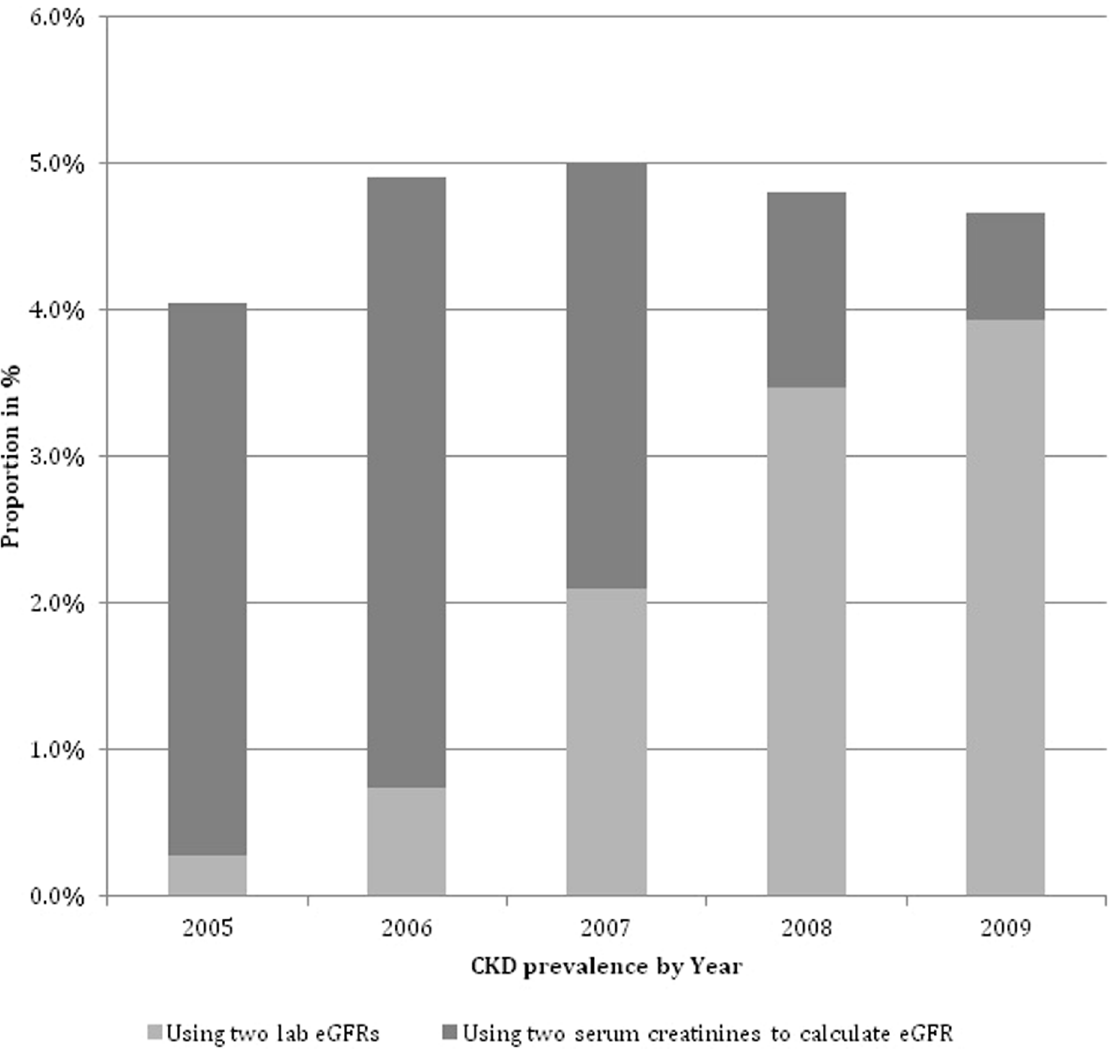
Figure 3. Prevalence of CKD by year combining CKD stage derived from laboratory eGFRs and eGFR calculated from serum creatinine.